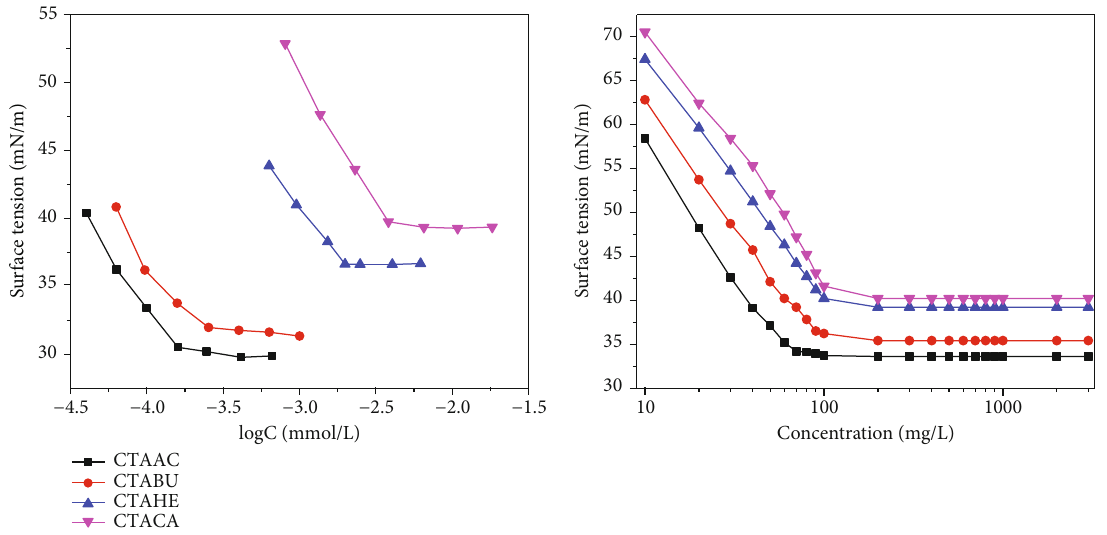
Figure 2: Surface tensions of surfactants in aqueous solutions at the room temperature.